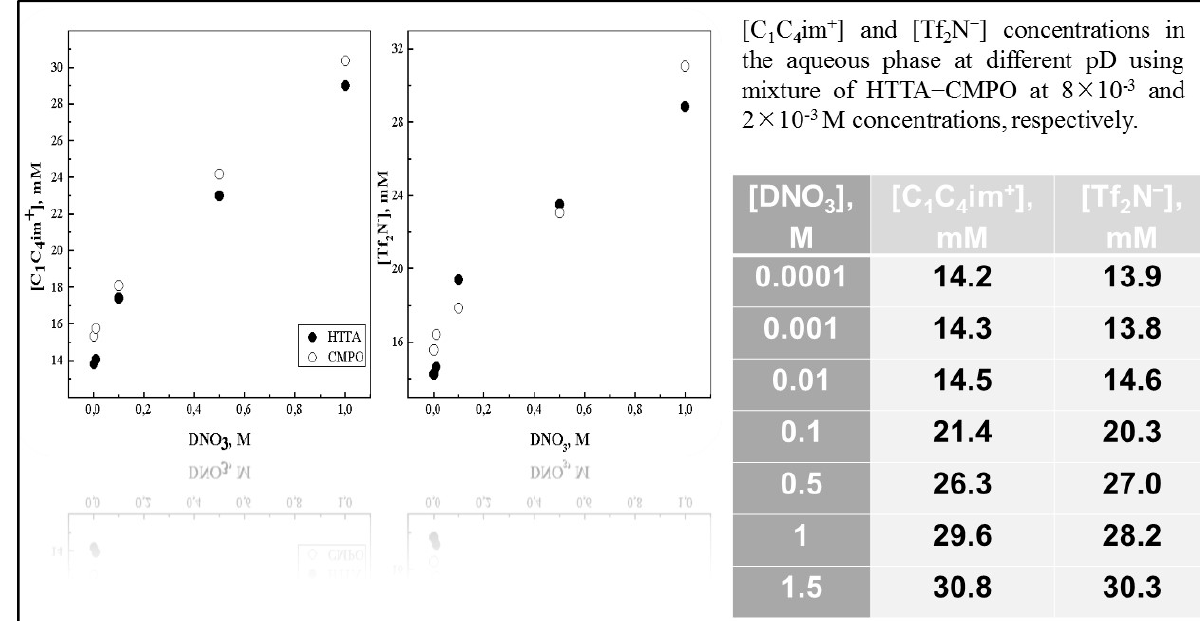
Figure 11. [C 1 C 4 im + ] or [Tf 2 N − ] vs. [DNO 3 ] of the aqueous phase using [C 1 C 4 im + ][Tf 2 N − ] as organic medium in the presence of ligands [HTTA] = 8 × 10 − 3 M and [CMPO] = 2 × 10 − 3 M. Adaptation from Ref. [78] with permission.